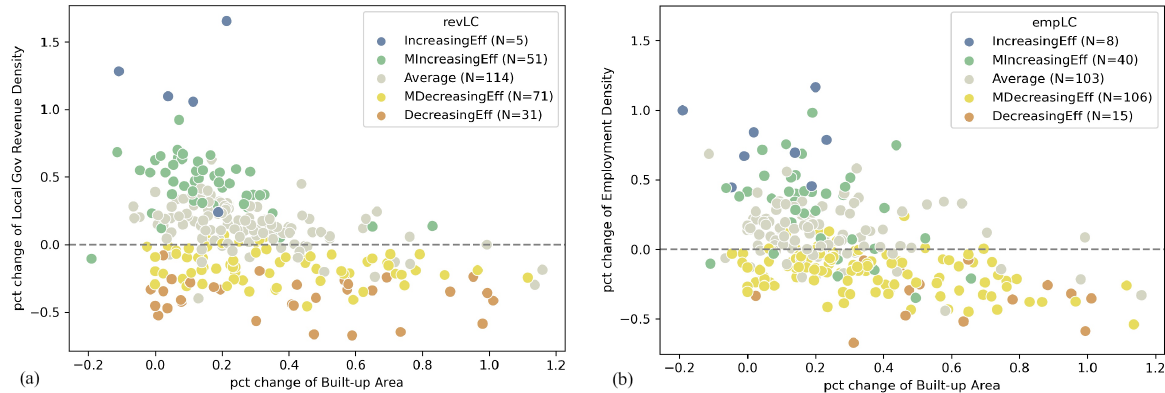
Figure 4. (a) Scatter plot of percentage change of built-up area and local government revenue density by class membership of Model 2a; (b) Scatter plot of percentage change of built-up area and employment density by class membership of Model 2b